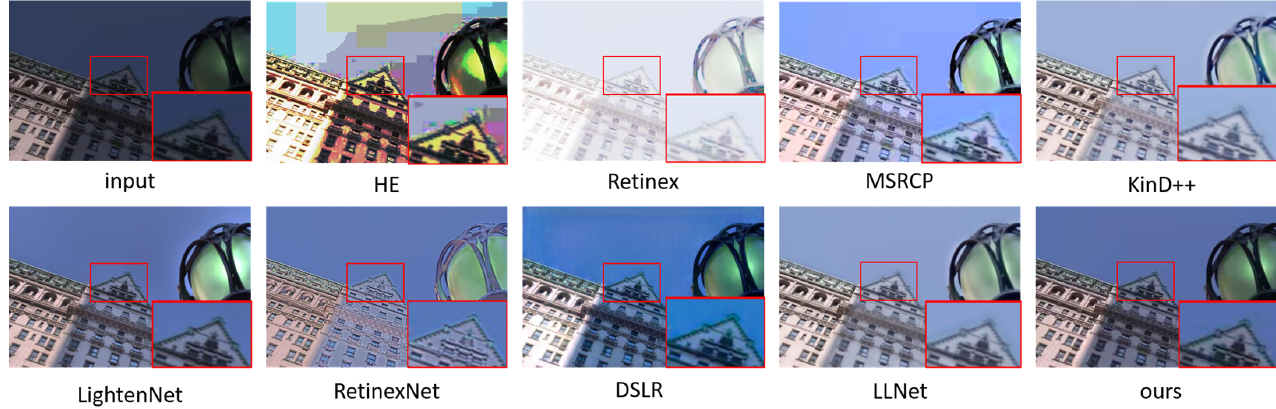
Figure 7. Visual comparison of enhanced renderings of low-illumination images.